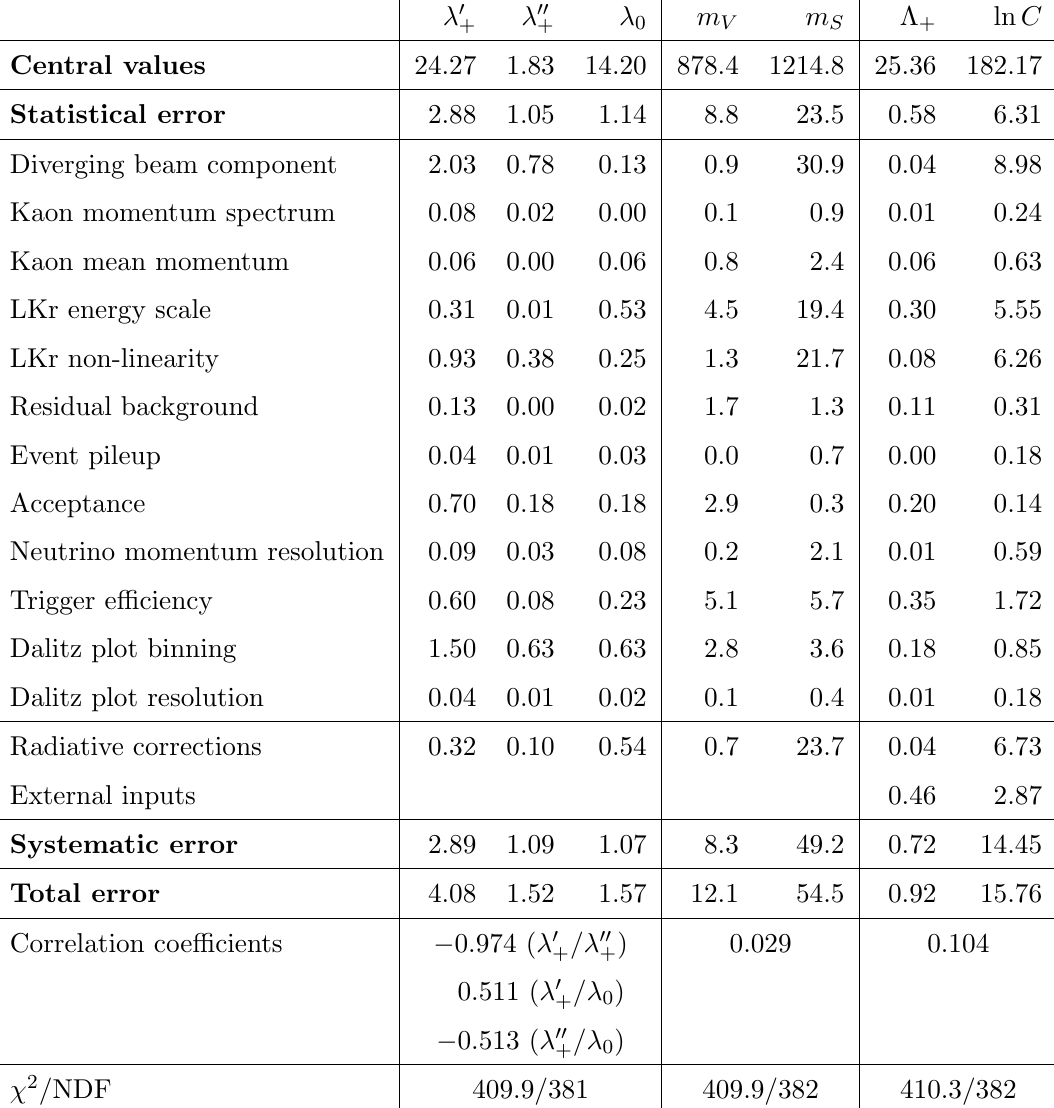
Table 4 . Form factor results of the K (cid:6) systematic uncertainties. The units of (cid:21) 0 units of m V and m S values and errors are MeV = c 2